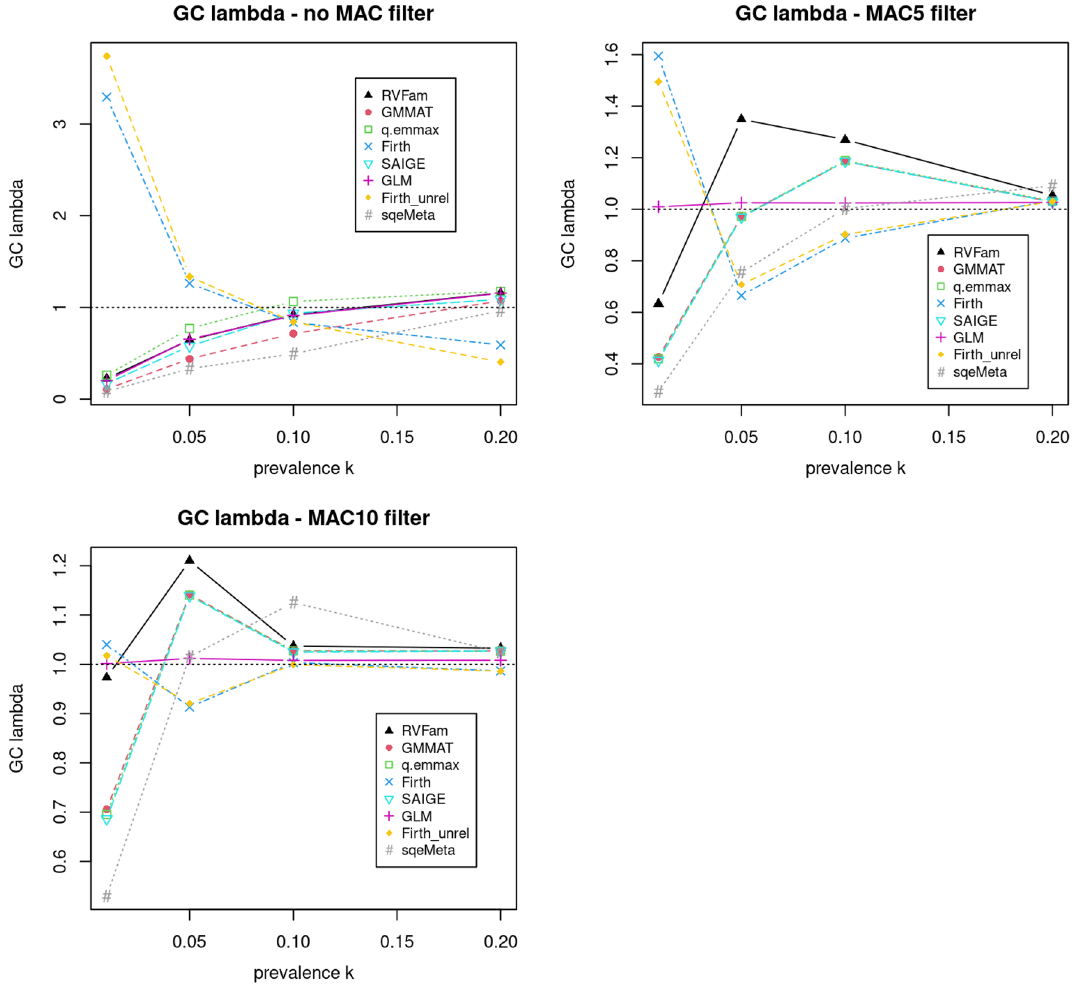
Figure 2. Plot of average genomic control parameter (λ) estimate from 100 replicates versus prevalence k in the first simulation study for evaluating type I error rates in SVT without minor allele count (MAC) filter (top left), with MAC5 filter (top right) and with MAC10 filter (bottom left).